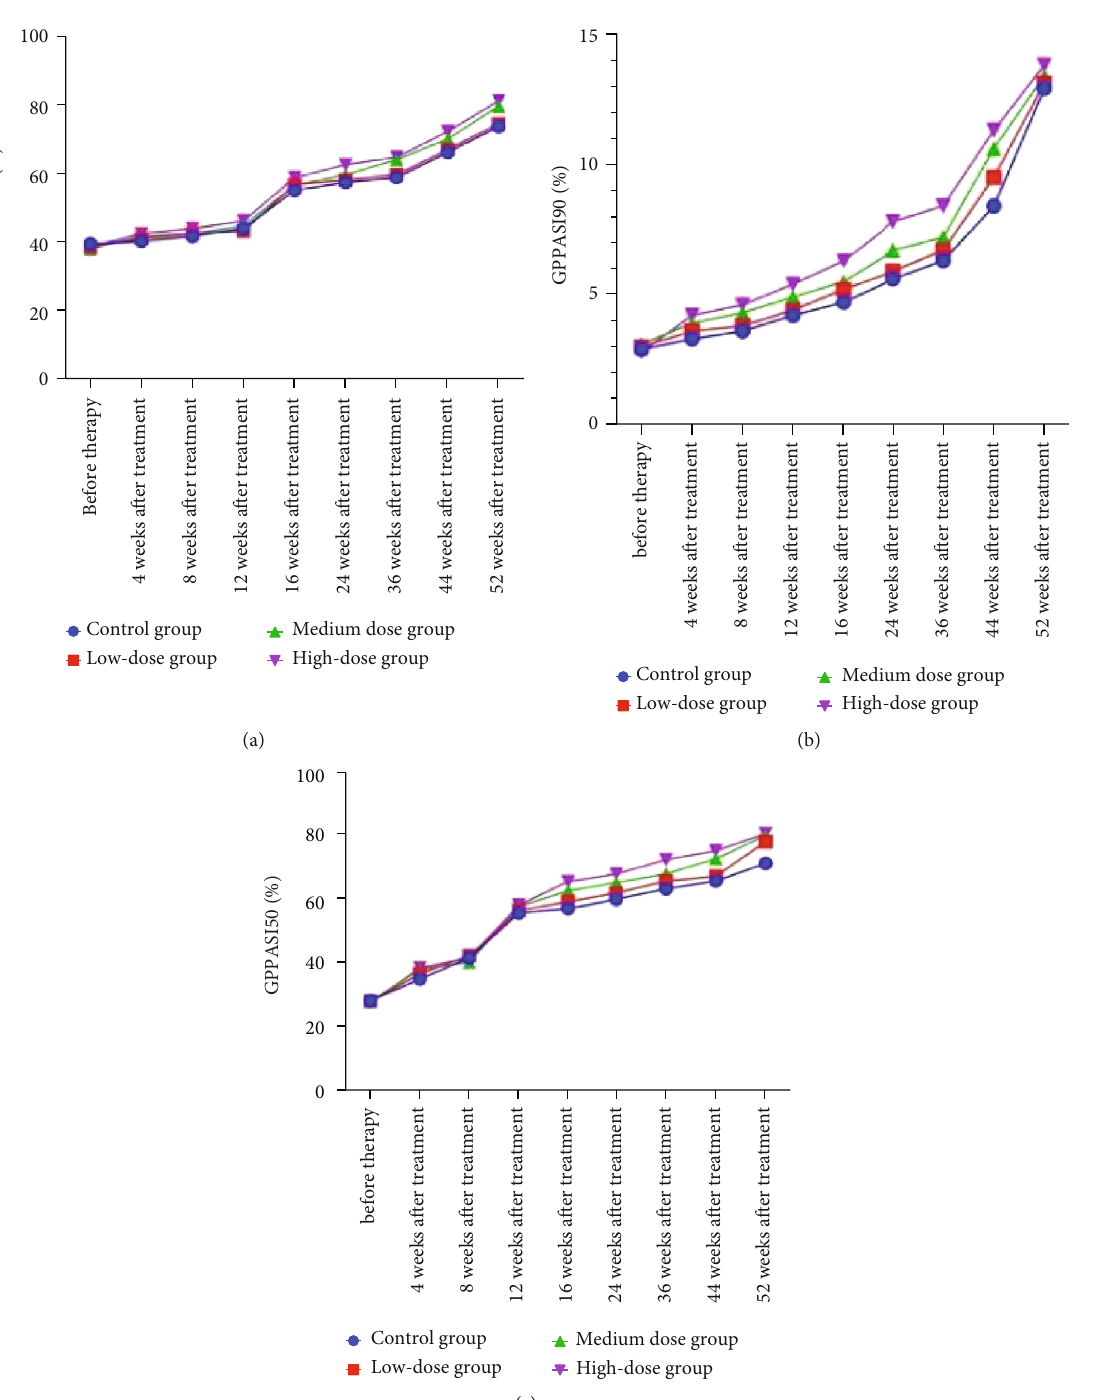
Figure 1: Comparison of the improvement rates of GPPASI50, GPPASI75, and GPPASI90 with four